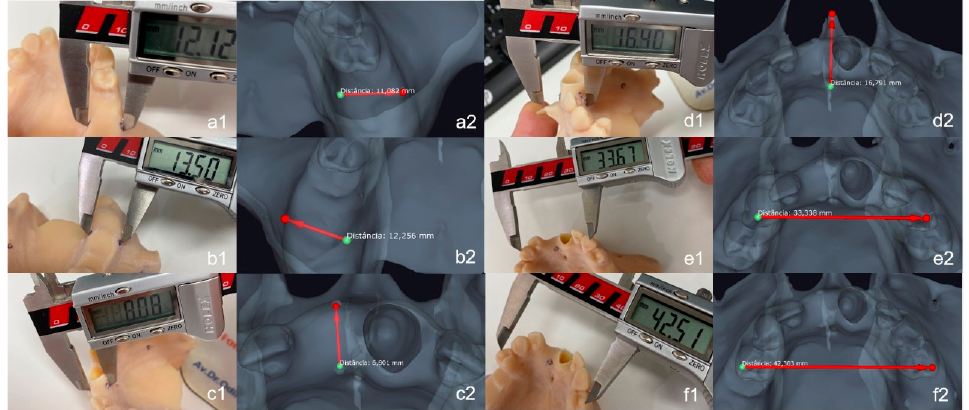
Figure 2. Example of digital and analog measures taken in the 3D analysis software. ( a ). Left posterior buccal–lingual width with markers; ( b ). Right posterior buccal–lingual width with markers; ( c ). anterior buccal–lingual width with markers; ( d ). Distance between anterior nasal spine and infraorbital foramen; ( e ). Distance between tip of cusps of teeth 13 and 23; ( f ). Distance between tips of cusps of teeth 14 and 24. Test measurements with digital caliper (1) and control digital measurements on the CAD software in occlusal view (2).